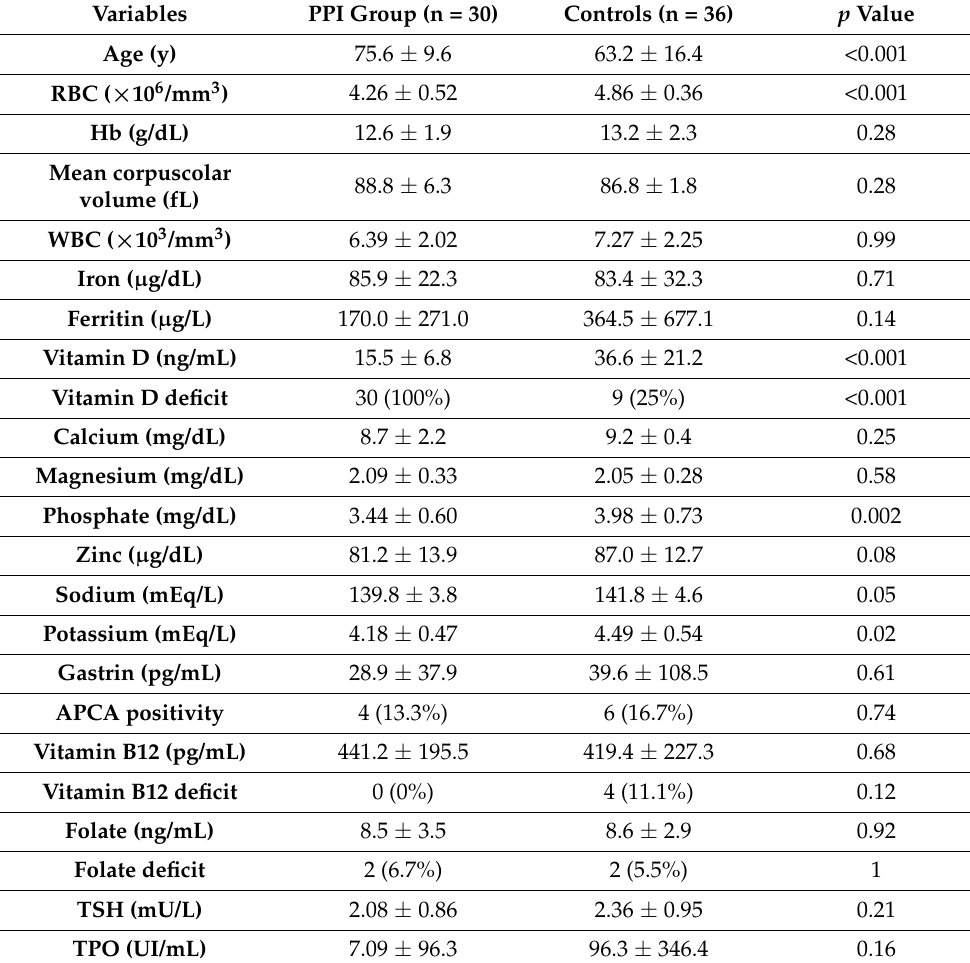
Table 1. Characteristics and laboratory values of the studied population (mean ± SD or